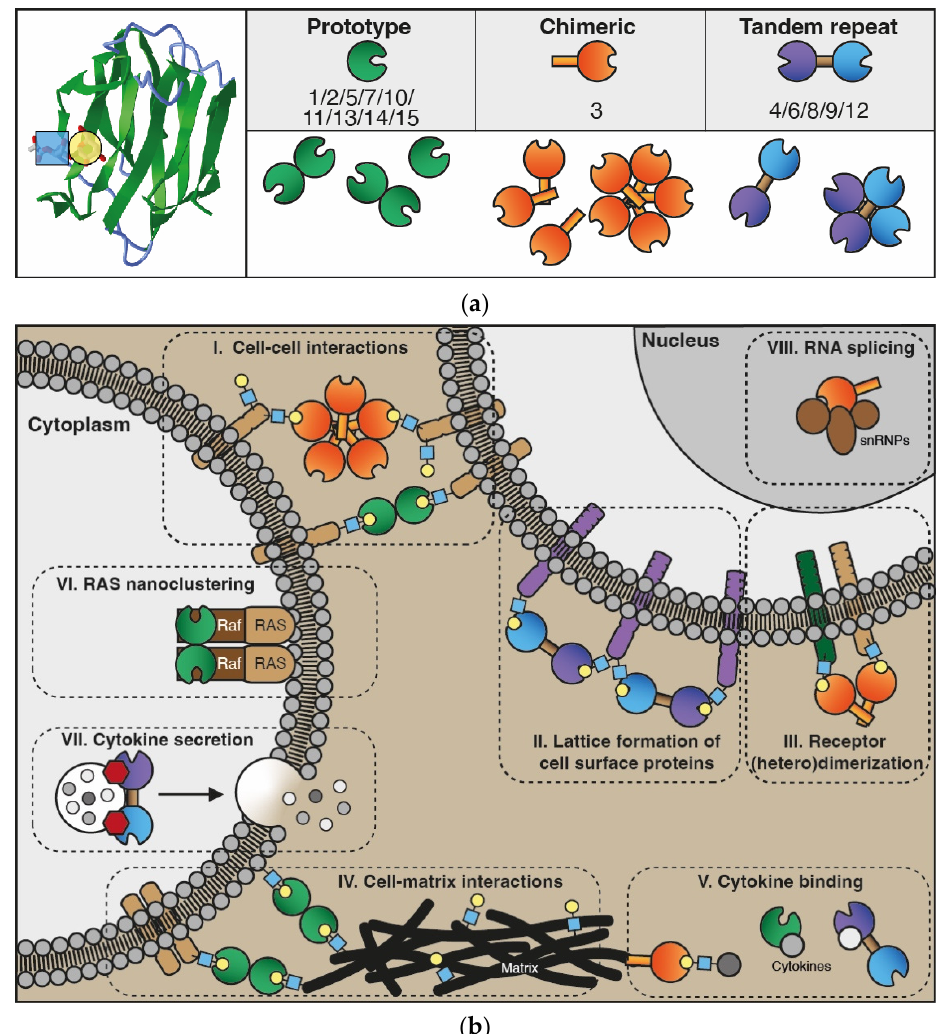
Figure 1. The galectin protein family. ( a ) Left panel: Cartoon of the anti-parallel beta-sheet structure forming the carbohydrate recognition domain of galectin-1 (in green). On the left, the interaction of a LacNAc (N-acetyllactosamine; blue-yellow) moiety in the binding groove is shown. Right panel: Overview of the 15 galectins that are expressed in humans. See text for explanation of the subgroups. ( b ) Cartoon depicting some of the key functions of galectins intra- and extracellularly. For more detailed information, refer to the reviews referred to in the main text. In the extracellular environment and on the cell surface, galectins can interact with glycoconjugates (blue-yellow) to facilitate, e.g., cell–cell interactions (I) and cell–extracellular matrix interactions (IV) to enable cell adhesion and migration. In addition, extracellular galectins can mediate interactions between molecules in the cell membrane to stimulate, e.g., lattice formation (II) and receptor dimerization (III), thereby promoting receptor cell surface retention and cell signaling. More recently, galectins were also found to heterodimerize with cytokines (V), affecting both galectin and cytokine activity. In the cytoplasm, galectins have been shown to engage in protein–protein interactions that facilitate, e.g., H-Ras nanocluster formation (VI) and signaling as well as cytokine secretion (VII). Finally, in the nucleus, galectins can interact with small nuclear ribonucleoproteins (VIII) thereby contributing to mRNA splicing.